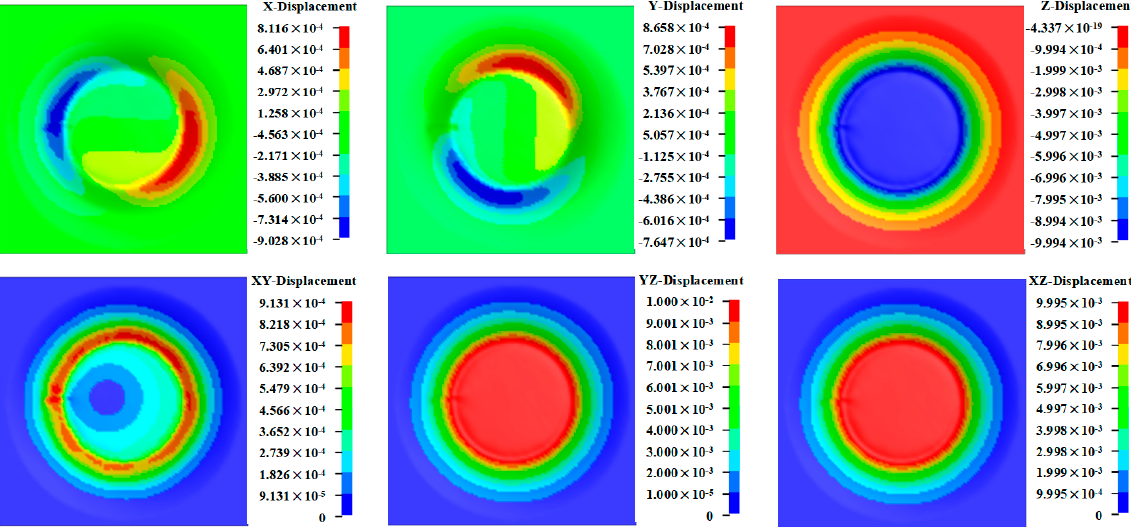
Figure 13. Cloud map of titanium plate displacement field.